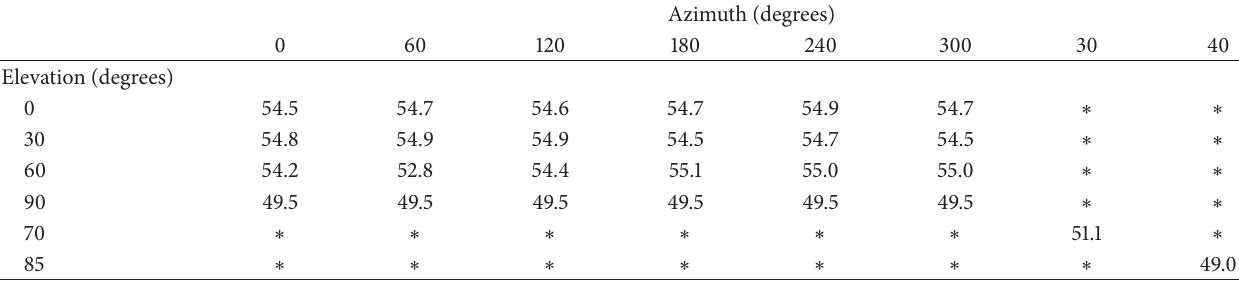
Table 5: Changing interference incident angle: 𝐶/𝑁 0 (in